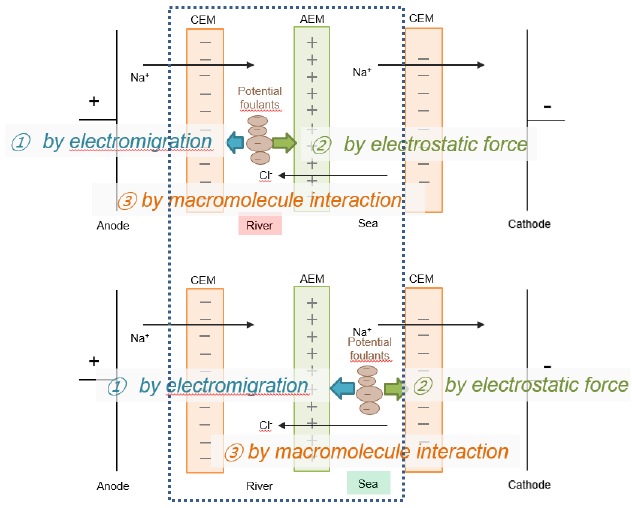
Figure 2. Schematic diagrams of the potential IEM fouling phenomena in the presence of foulants in a river stream ( top ) and a seawater stream ( bottom ) in RED with only one cell pair (the part within the dashed